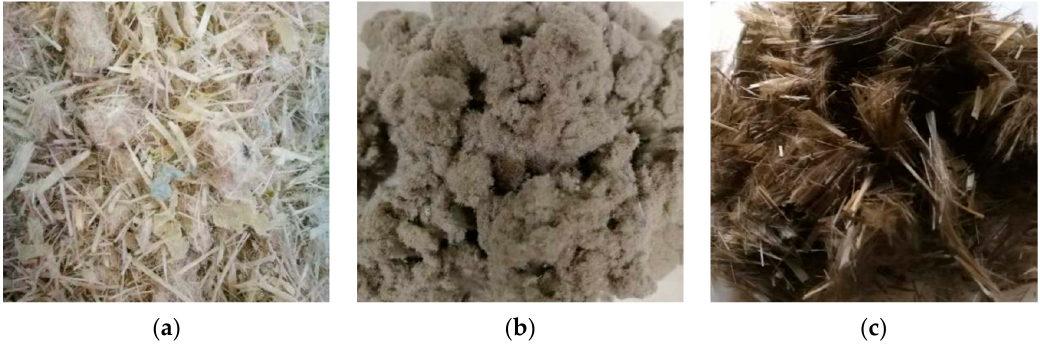
Figure 1. Selected fibers: ( a ) fiber-reinforced plastic (FRP); ( b ) lignin fiber; ( c ) basalt fiber.